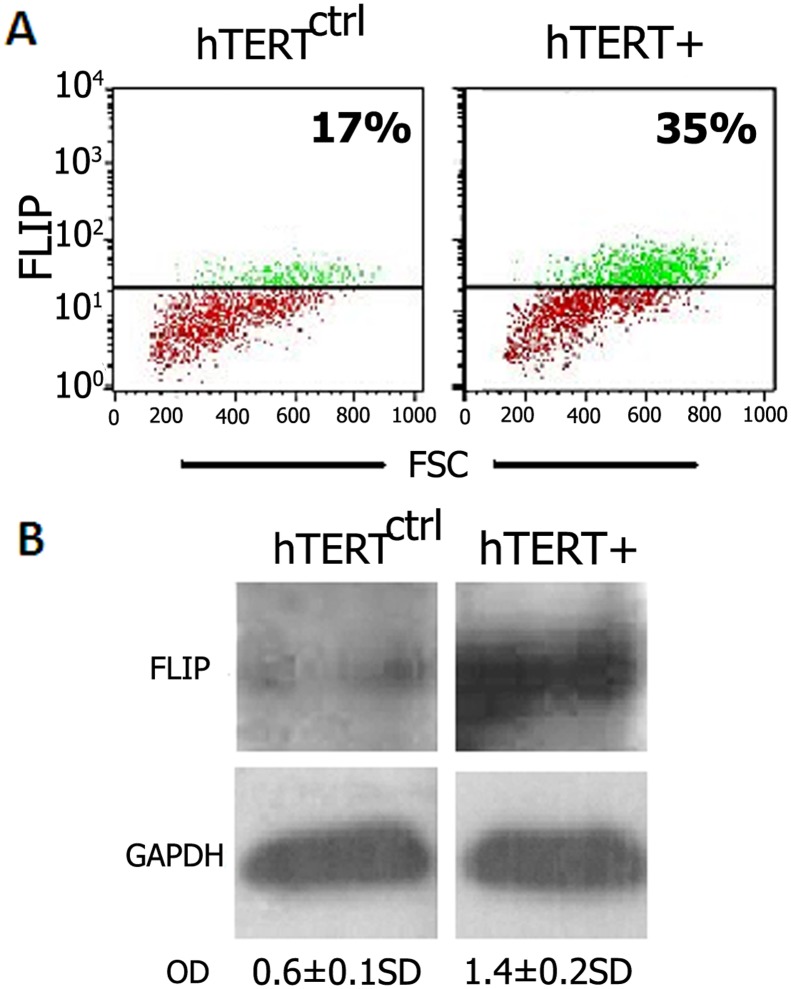
FLIP is upregulated in hTERT+ vs. hTERTctrl transfected MLE cells.(A) Flow cytometry dot plots of FLIP expression, and (B) Western blot using anti-FLIP mAb in hTERT+ vs. hTERTctrl (control) transfected cells. OD ratios showing increased FLIP in hTERT+ mouse lung MLE epithelial transfected cells are presented. Representative results of two different experiments for each assay, with similar results.